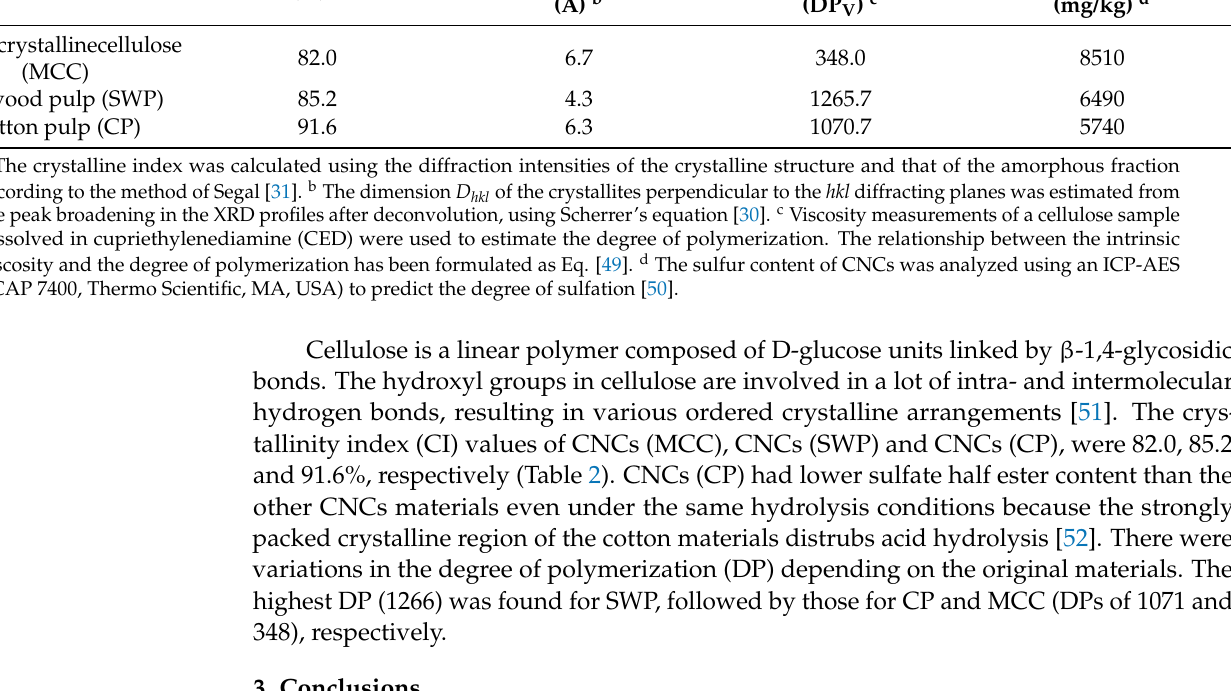
Figure S2: A scatter plot graph and correlation analysis results for the isolation degree of CNCs and suspension stability: CNCs(MCC); Square, CNCs(SWP); Circle, CNCs(CP); Triangle, Figure S3: Stability of CNCs suspensions accordance with multisample analytical centrifuge (LUMiSizer®)